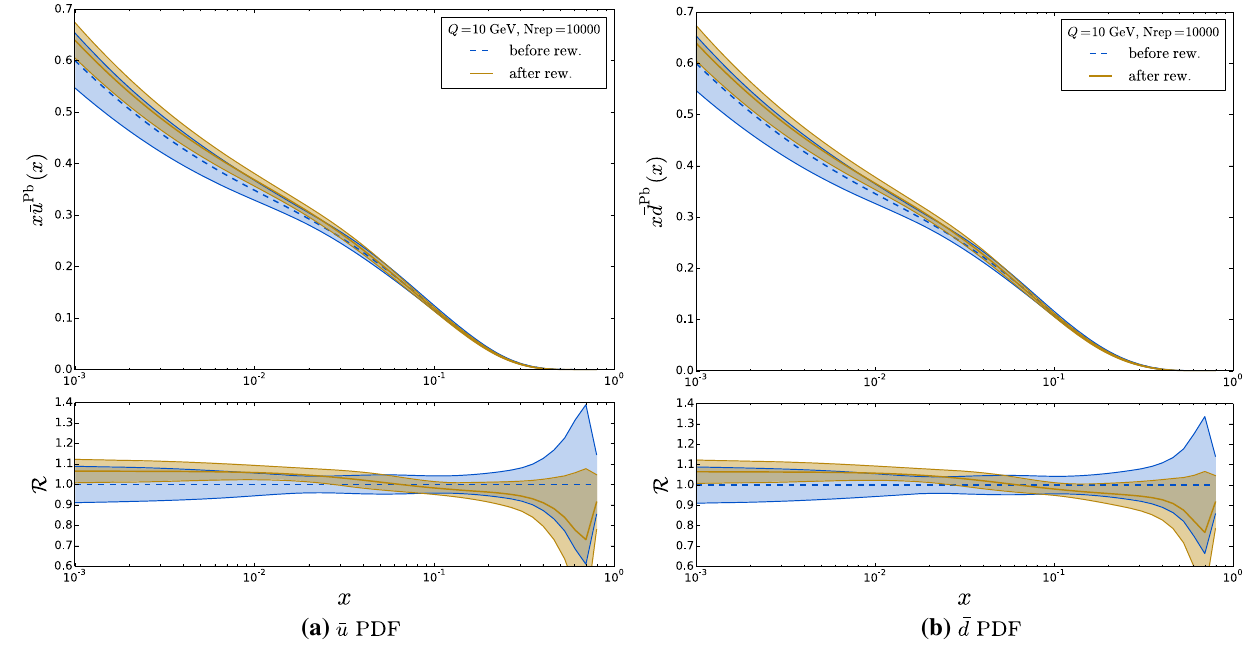
Fig. 28 ¯ u and ¯ d PDFs before and after the reweighting using all LHC pPb data